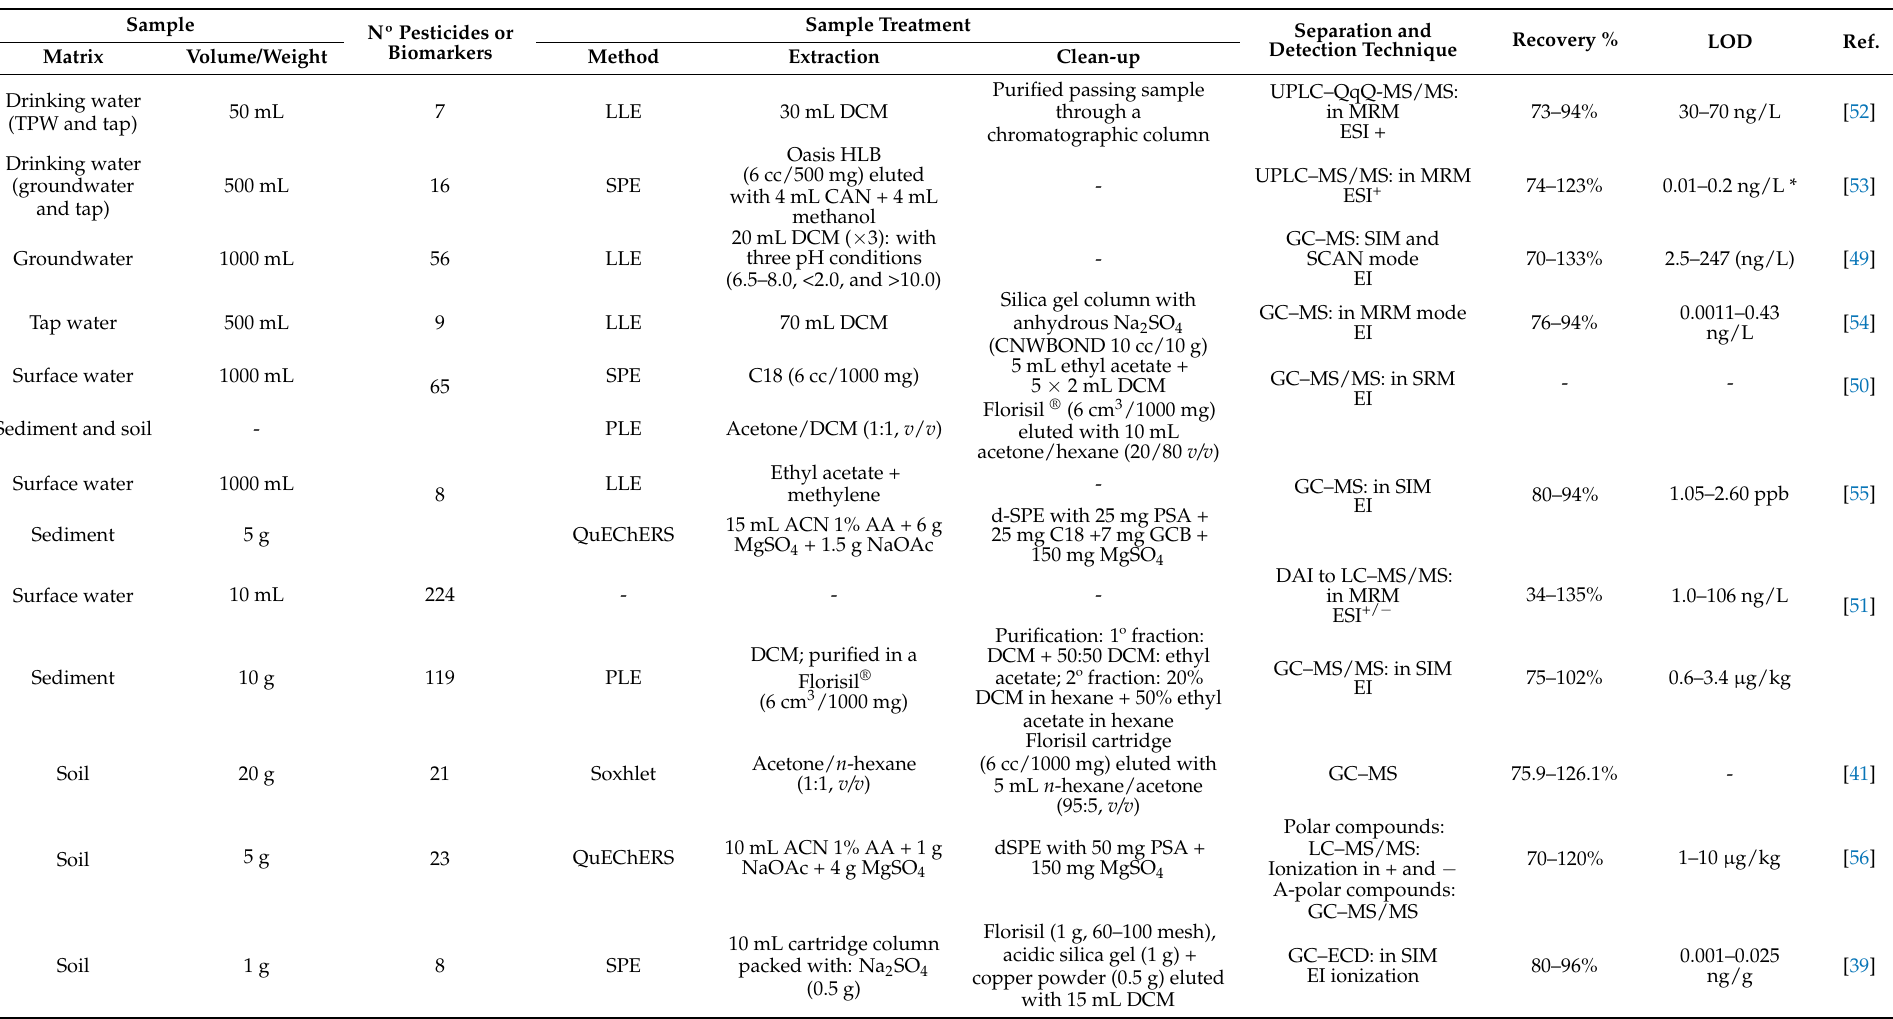
Table 1. Selected analytical methods published between 2019 and 2021 for the analysis of pesticides in environmental matrices and food to analyze human